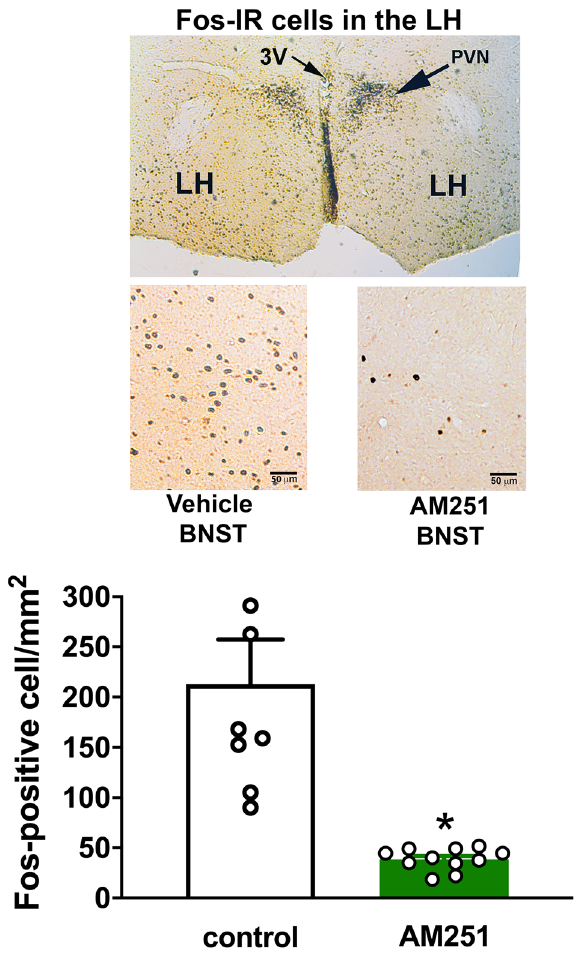
Figure 1. Effect of bed nucleus of the stria terminalis (BNST) treatment with the CB 1 receptor antagonist AM251 in the number of Fos-immunoreactive (IR) cells in the LH following exposure to a 60-min session of restraint stress. (Top) Representative coronal sections showing Fos-IR cells in the LH following restraint stress exposure in animals that received bilateral microinjection of vehicle or AM251 into the BNST (bottom), as well as a representative section indicating the LH location (top). 3V third ventricle, LH lateral hypothalamus, PVN paraventricular nucleus of the hypothalamus. (Bottom) Number of Fos-IR cells in the LH following exposure to acute restraint stress in animals treated with vehicle [solution of saline containing 30% of DMSO (DMSO), 100 nL, n = 8] (white bar) or the selective CB 1 receptor antagonist AM251 (100 pmol/100 nL, n = 11) (green bar) into the BNST. The bars represent the mean ± SEM. * P < 0.05, Student’s t test.